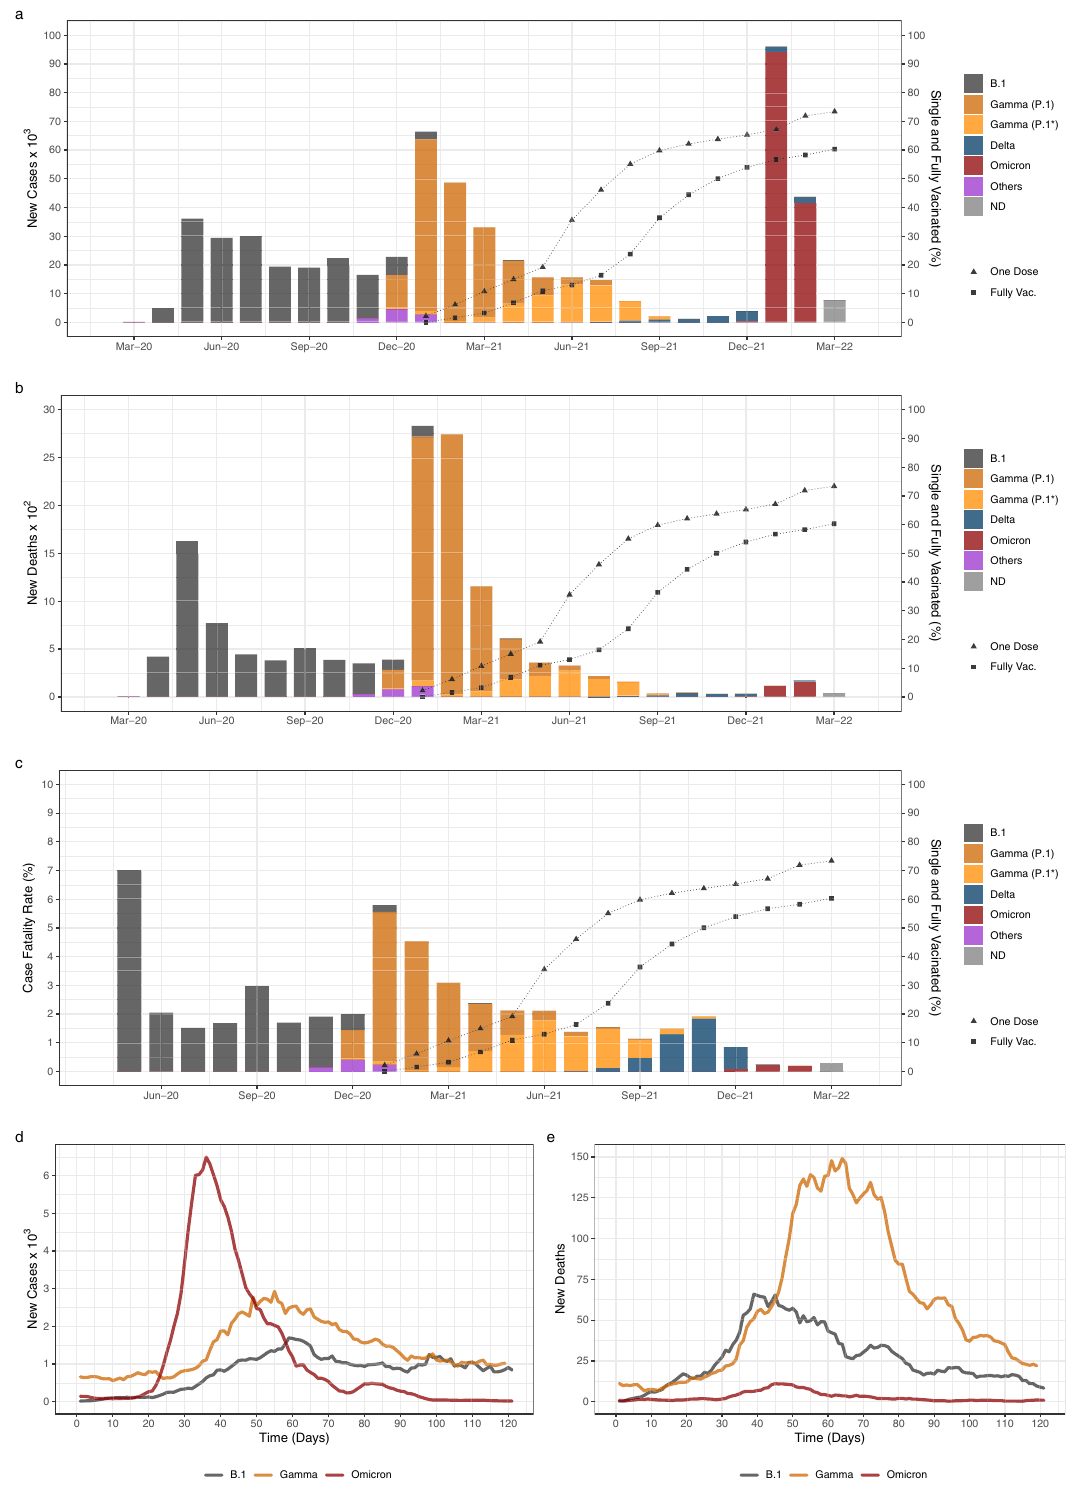
Fig. 2 | Epidemic trajectories of SARS-CoV-2 variants circulating in Amazonas. a – c Number of monthly con fi rmed SARS-CoV-2 cases ( a ), deaths ( b ), and